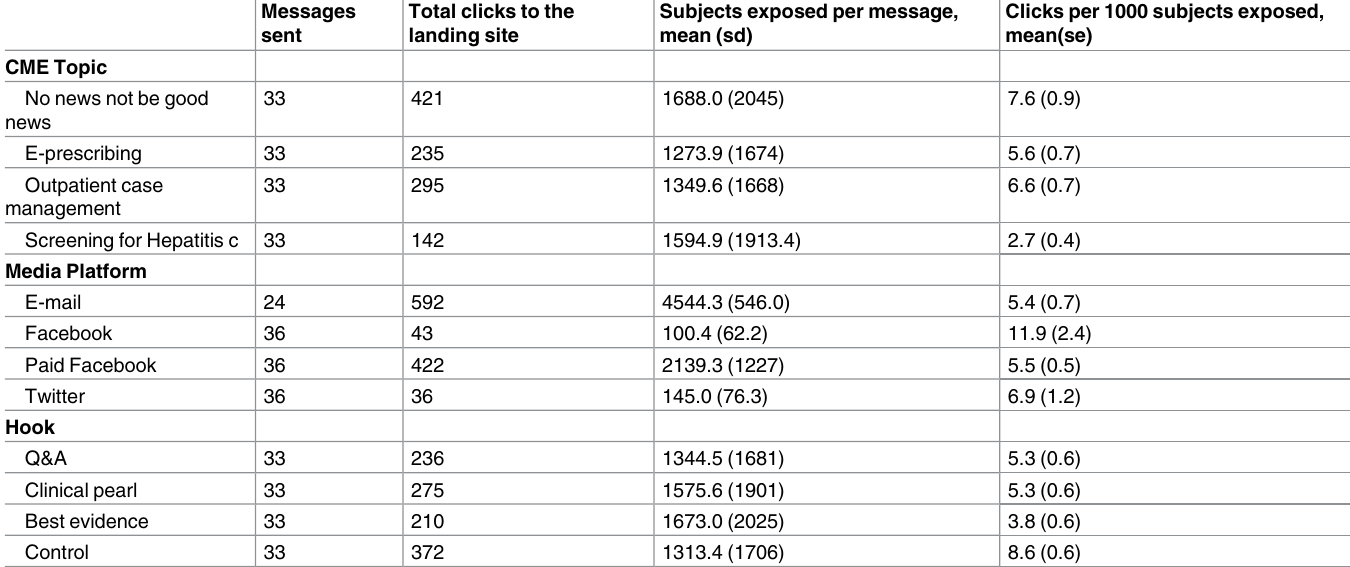
Table 1. Total clicks to the landing